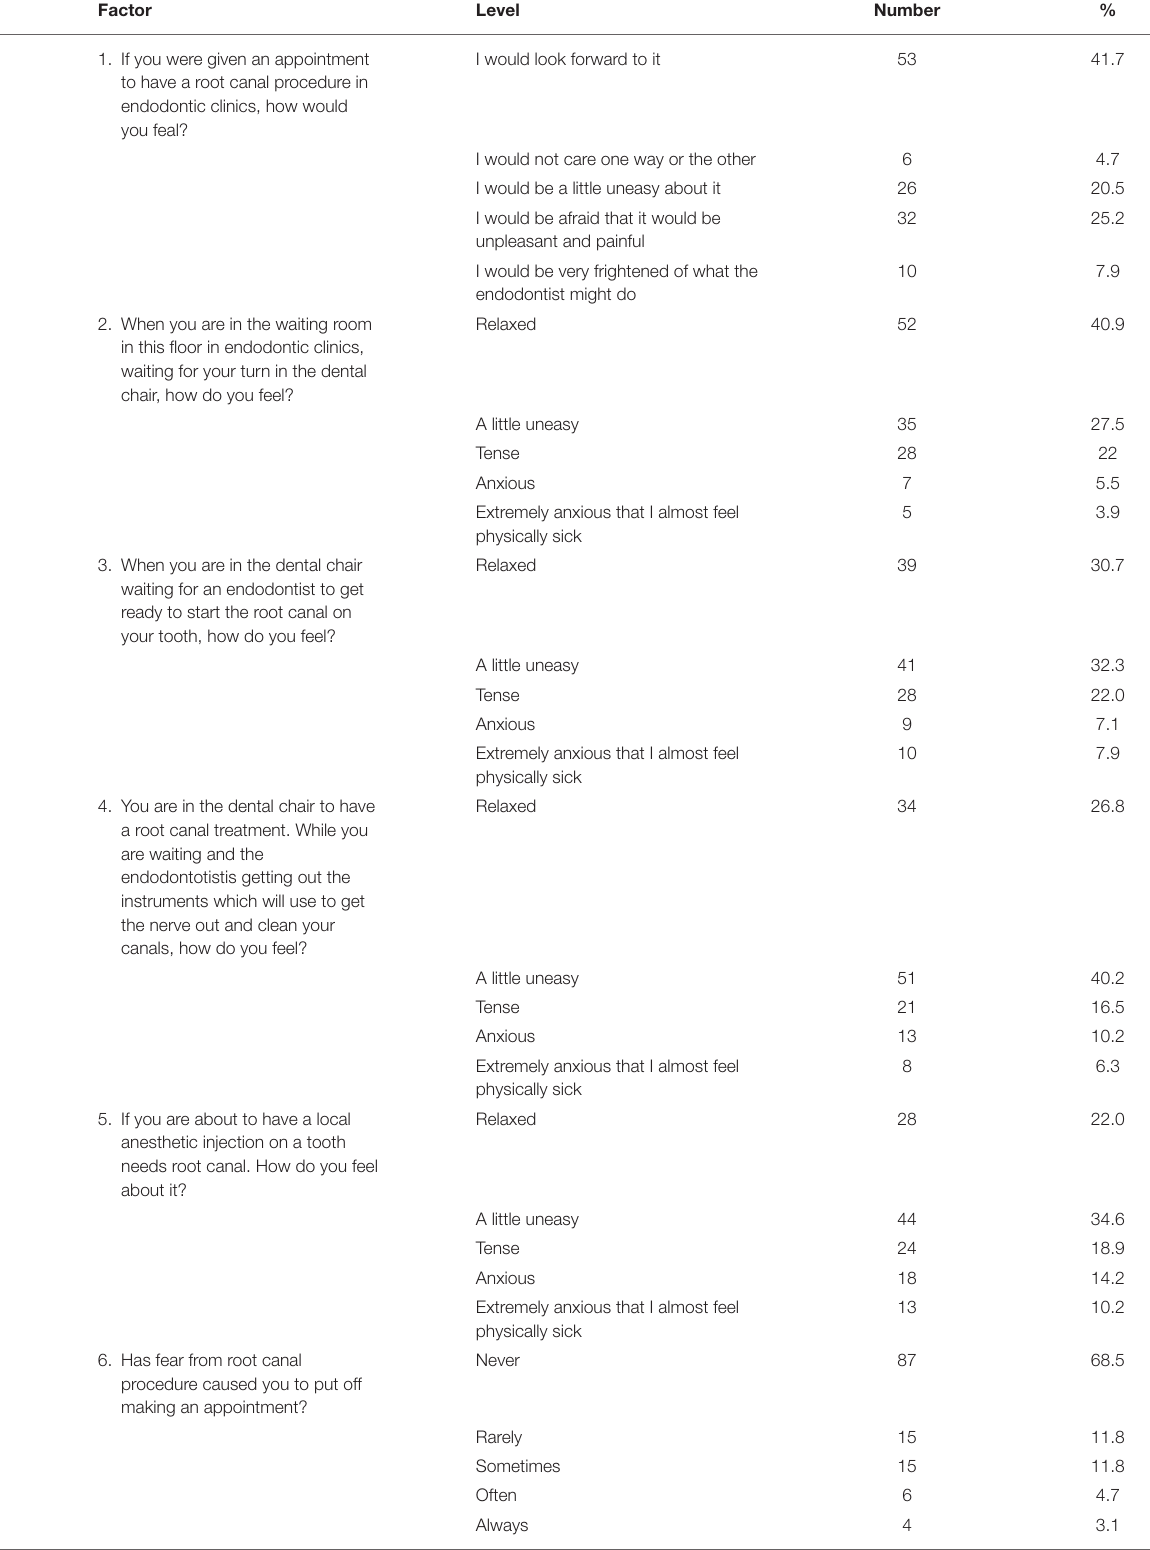
TABLE 1 | Modified Dental Anxiety Scale (MDAS), Dental Fear Survey (DFS), and baseline demographics questionnaires. Reference Factor Level Number % Pre treatment